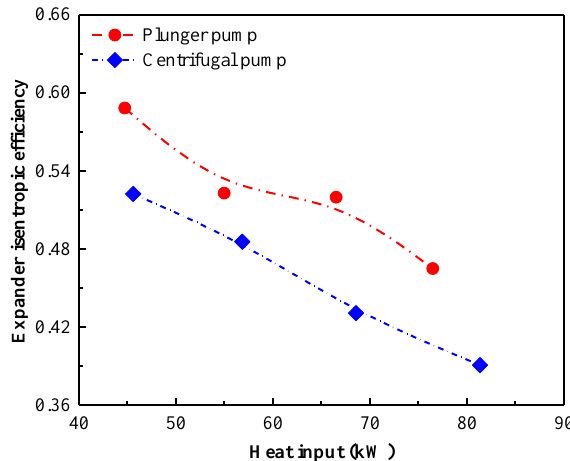
Figure 12. Expander isentropic e ffi ciency with heat input using the plunger pump and centrifugal pump.